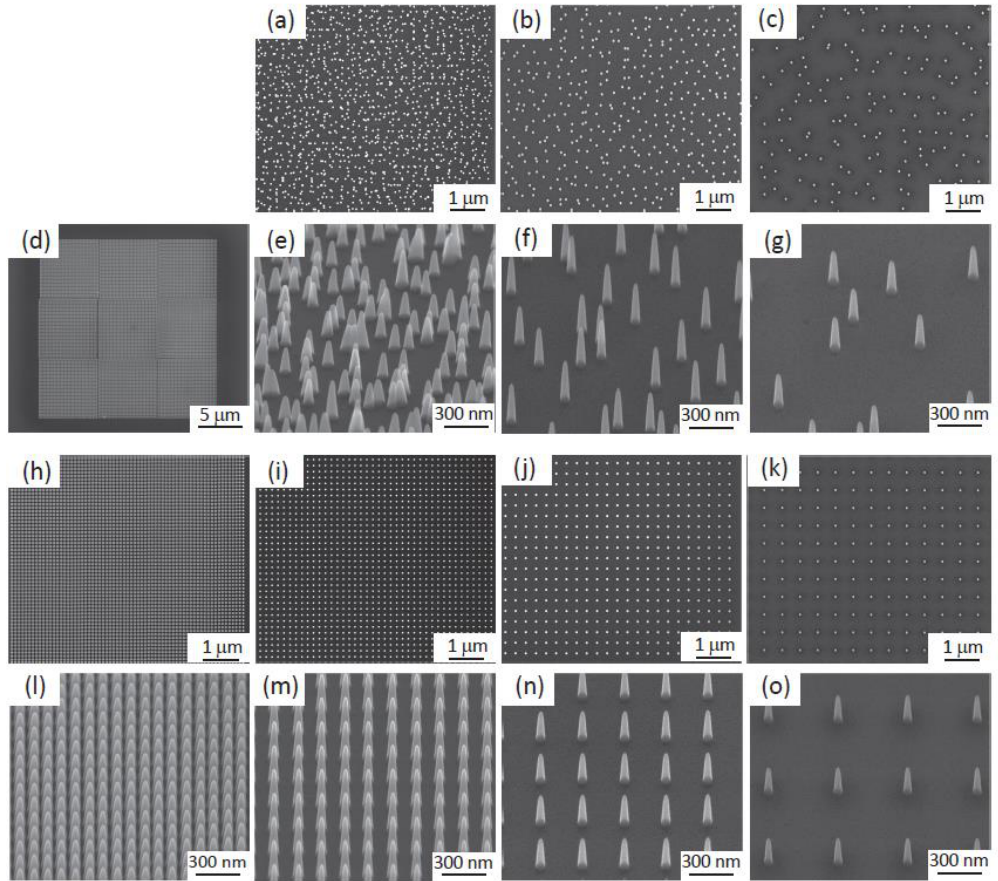
Figure 1. The scanning electron microscope (SEM) images of ( a ) the top view of the nanopillars with a height of 190 nm, a diameter of 80 nm, and an interspacing of 170 nm with 45 nm disorder distance (170 D) ; ( b ) the top view of the nanopillars with an interspacing of 300 nm and 110 nm disorder distance (300 D ); ( c ) the top view of the nanopillars with an interspacing of 500 nm and 210 nm disorder distance (500 D ); ( d ) 20 × 20 µm 2 nanopatterned areas on a Si substrate; ( e ) the tilted view of 170 D ; ( f ) the tilted view of 300 D ; ( g ) the tilted view of 500 D ; ( h ) the top view of the ordered nanopillars with an interspacing of 100 nm (100 O ); ( i ) the top view of the ordered nanopillars with an interspacing of 170 nm (170 O ); ( j ) the top view of the ordered nanopillars with an interspacing of 300 nm (300 O ); ( k ) the top view of the ordered nanopillars with an interspacing of 500 nm (500 O ); ( l ) the tilted view of 100 O ; ( m ) the tilted view of 170 O ; ( n ) the tilted view of 300 O ; ( o ) the tilted view of 500 O .